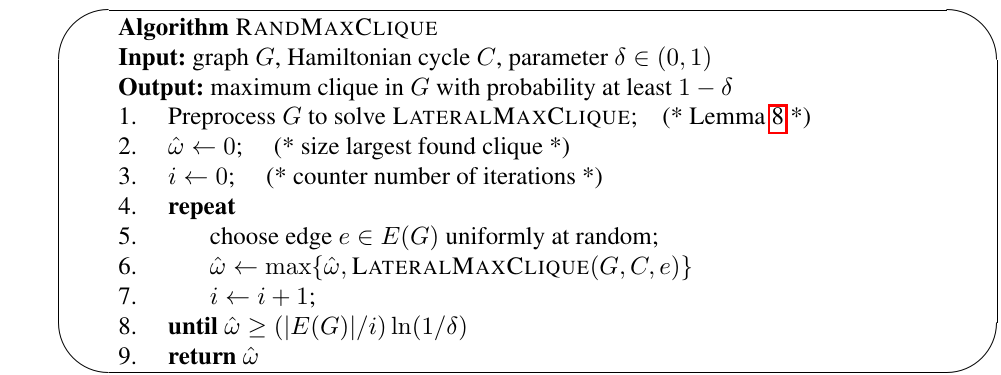
Figure 6: Algorithm R AND M AX C LIQUE